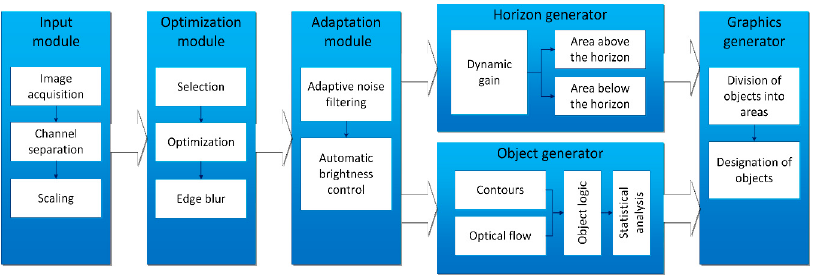
Figure 1. The structure of image processing algorithms.